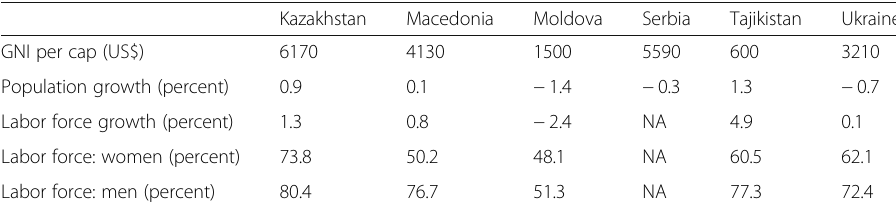
Table 1 Key macro indicators for the six transition economies: 2008 Kazakhstan Macedonia Moldova Serbia Tajikistan Ukraine GNI per cap (US$)